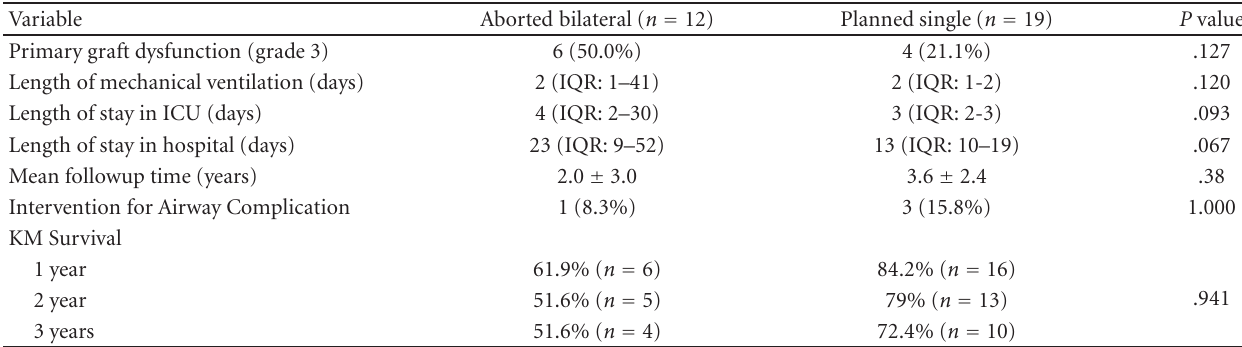
Table 2: Followup and outcomes